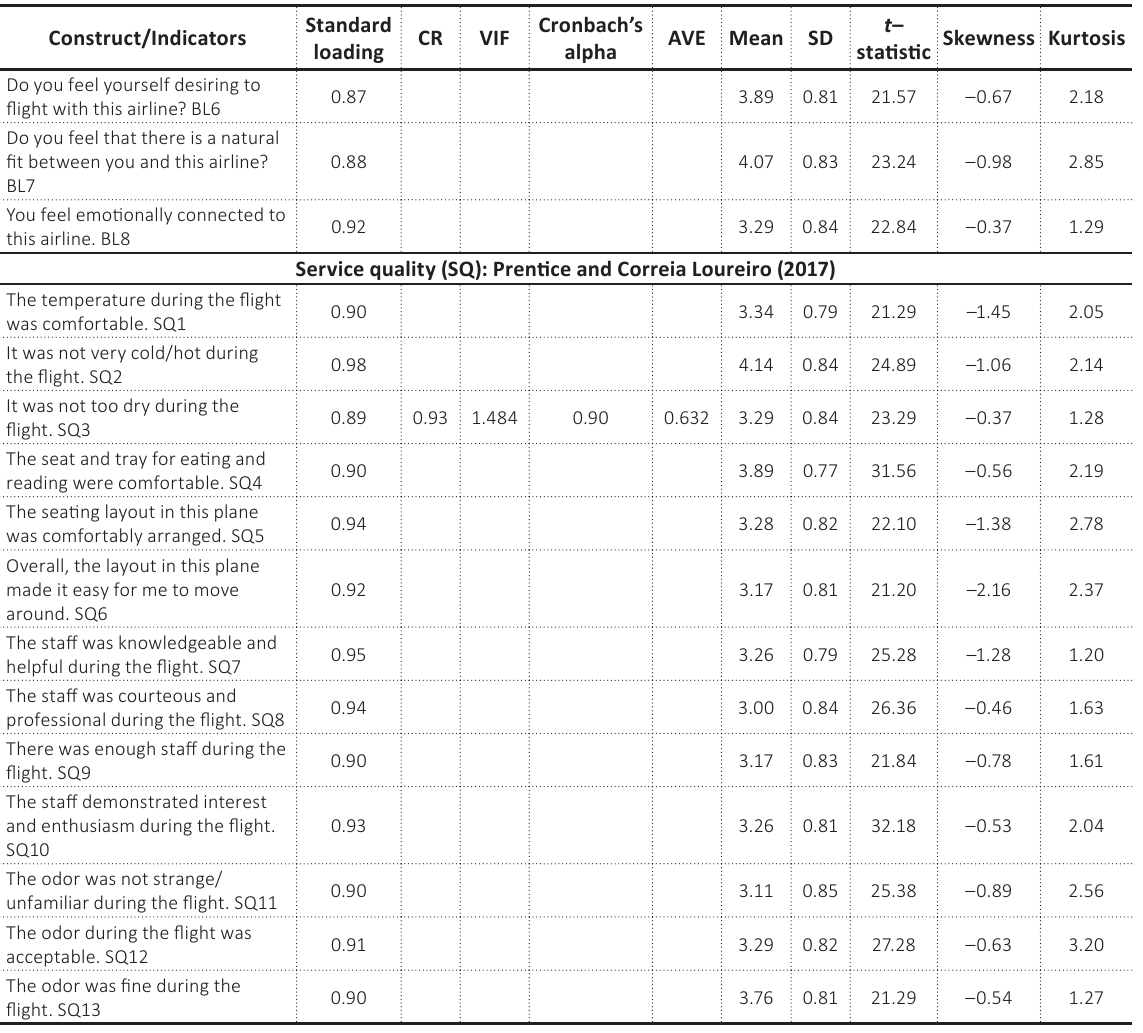
Table A1 (cont.). Measurement statistics of construct